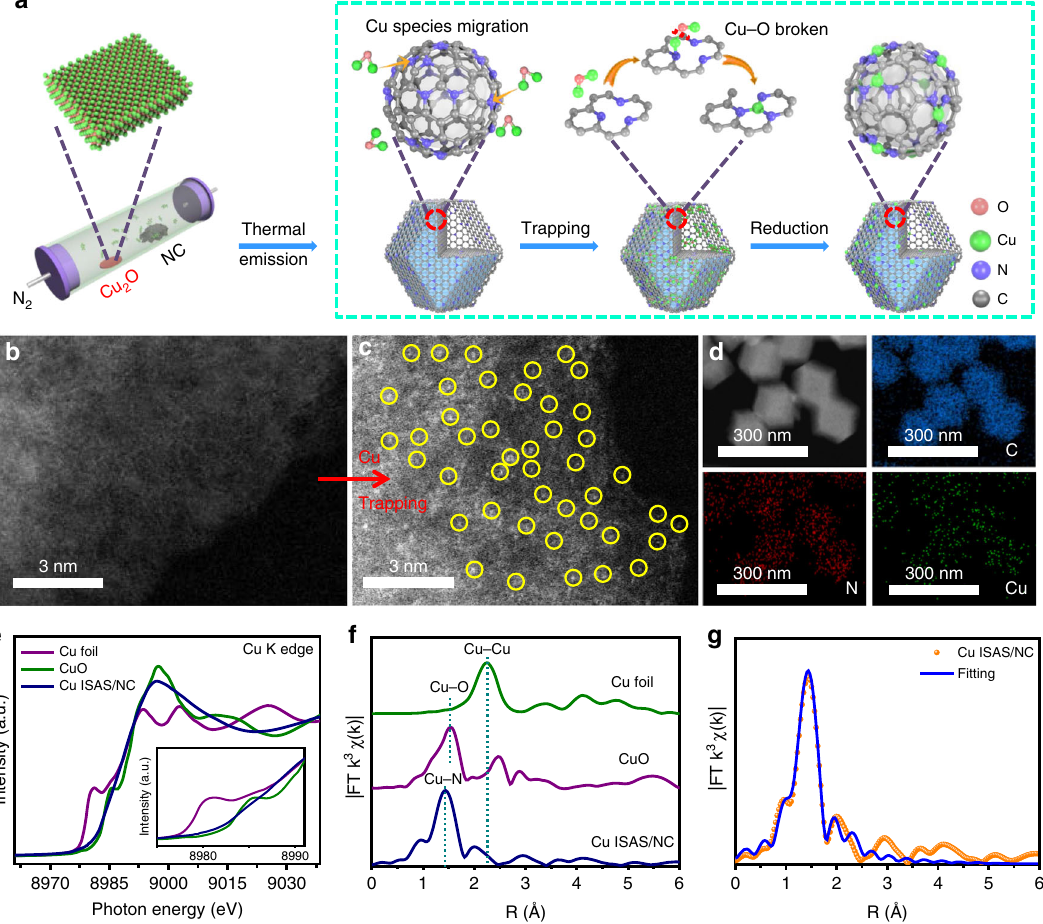
Fig. 1 Synthesis and structural characterizations. a Scheme of the formation isolated copper sites (Cu ISAS/N-C) catalyst. b aberration-corrected high-angle annular dark- fi eld scanning transmission electron microscope (AC HAADF-STEM) image of NC. c AC HAADF-STEM image of Cu ISAS/NC. d Corresponding EDS mapping of Cu ISAS/NC. e Cu K-edge X-ray absorption near-edge structure (XANES) and f FT k 3 -weighted extended X-ray absorption fi ne structure (EXAFS) spectra of Cu ISAS/NC and the reference samples. g Corresponding FT-EXAFS fi tting curves of Cu